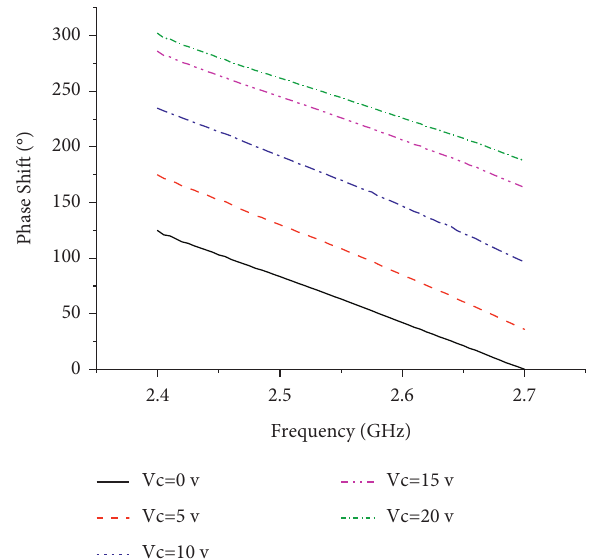
Figure 8: The measured phase shift of the reflection phase shifter under different loading voltages.